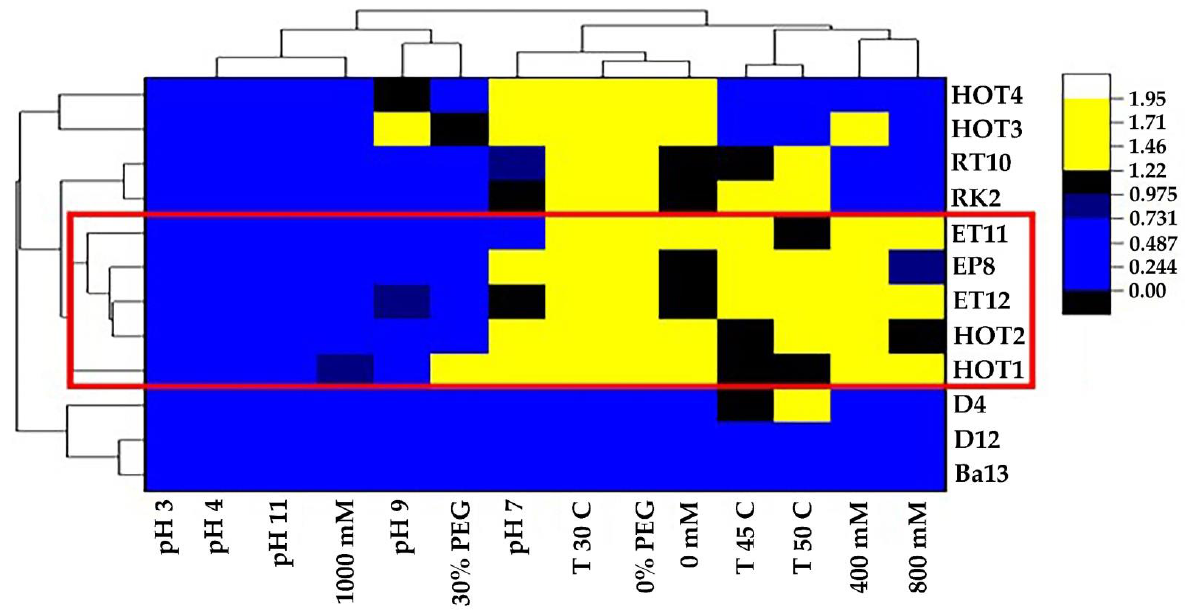
Figure 8. Heat map showing the response of the isolates to different stress tolerance (pH, temperature, NaCl, and PEG). The bacterial isolates (HOT1, HOT2, EP8, ET11, and ET12) having the best capacities are highlighted with the same colors.